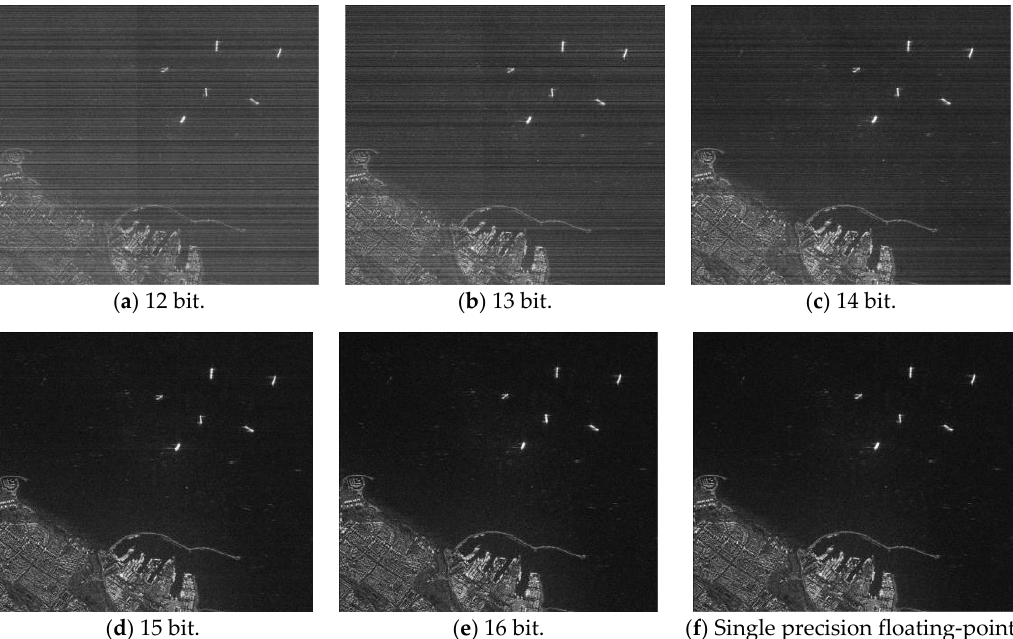
Figure 5. Actual scene imaging results (overall region) for different FFT processing accuracies. ( a – e ): 12- to 16-bit fixed-point FFT, ( f ) single precision floating-point FFT.